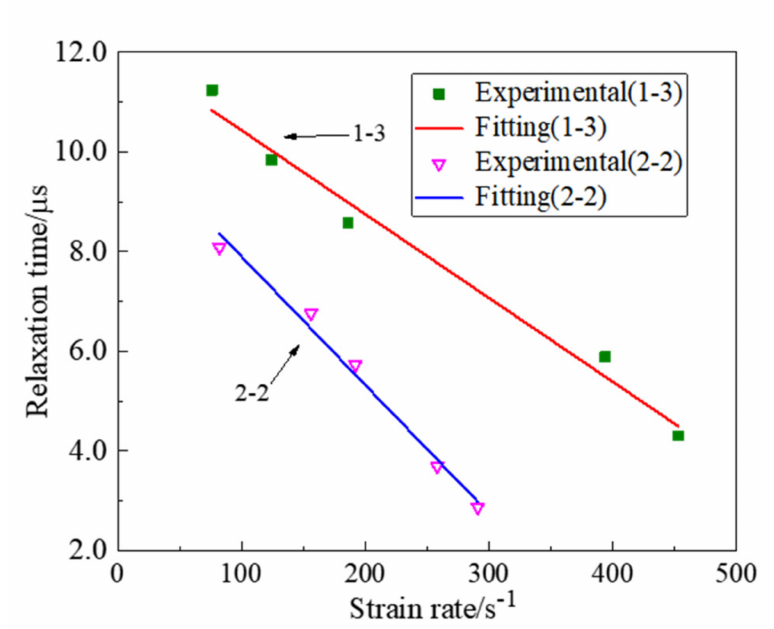
Figure 7. Relationship between relaxation time and strain